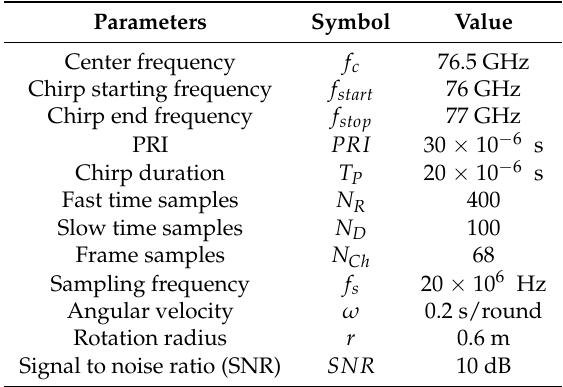
Table 1. MMWCSAR simulation setup. PRI, pulse repetition interval.